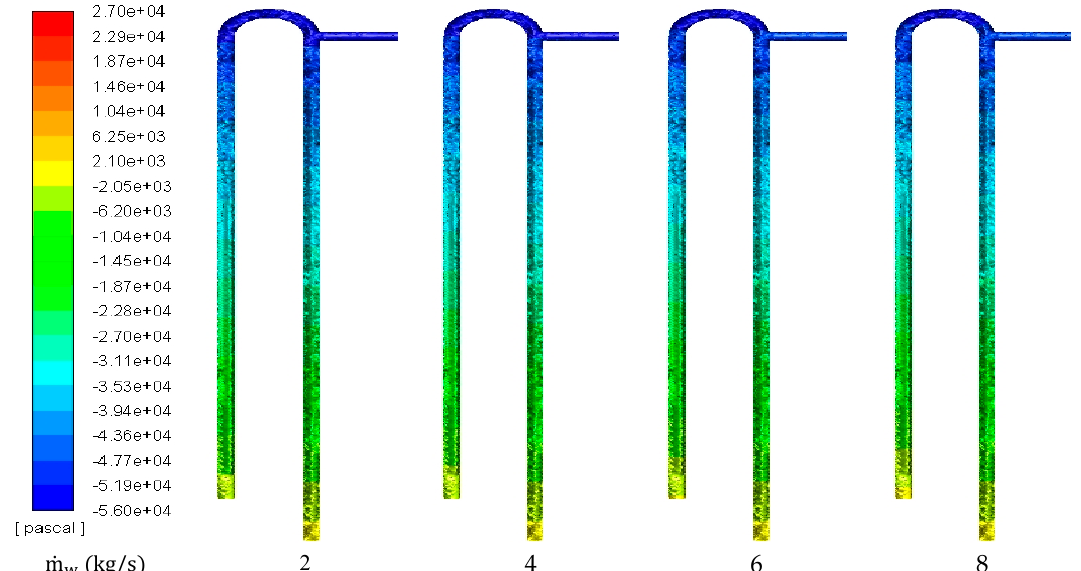
Figure 13. Pressure contours at di ff erent flow ratios and X w = 6187.64, α m = 0.2 and X v = 0.5. Figure 13. Pressure contours at different flow ratios and X (cid:2933) = 6187.64, α (cid:2923) = 0.2 and X (cid:2932) = 0.5 . Figure 13. Pressure contours at different flow ratios and X (cid:2933) = 6187.64, α (cid:2923) = 0.2 and X (cid:2932) = 0.5 .